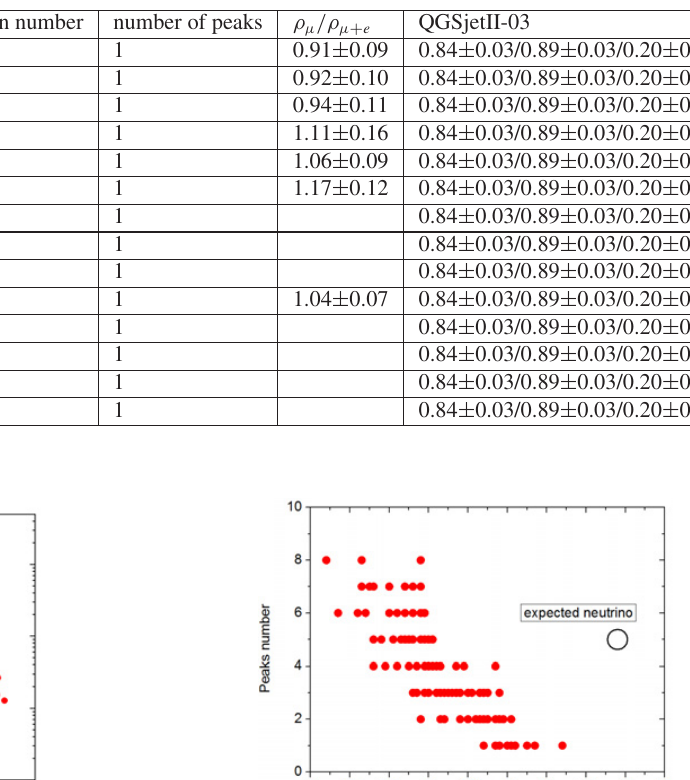
Table 1. Strongly inclined showers with energy E ≥ 1 · 10 19 eV and θ ≥ 60 ◦ .